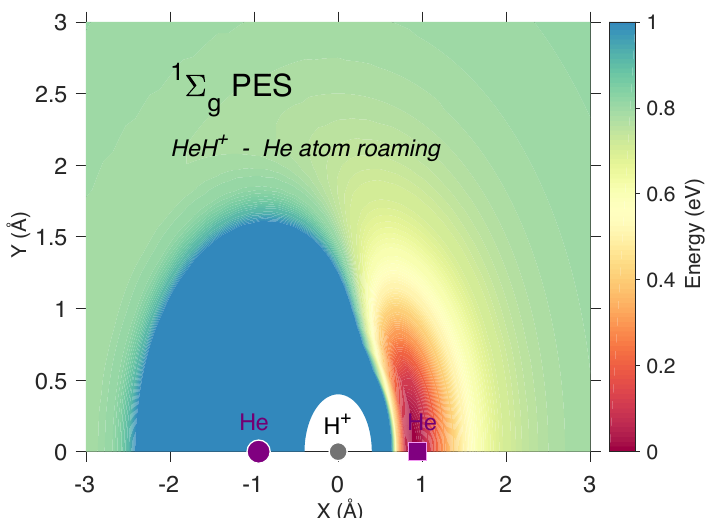
Figure 3. The two-dimensional Singlet HeH + + He PES in eV for the motion of the helium atom (purple square) around the fixed positions of the hydrogen and other helium atom (gray and purple circles, respectively) in the 1 Σ + g HeHHe + molecule. The minimum corresponds to the geometry of the 1 Σ + g